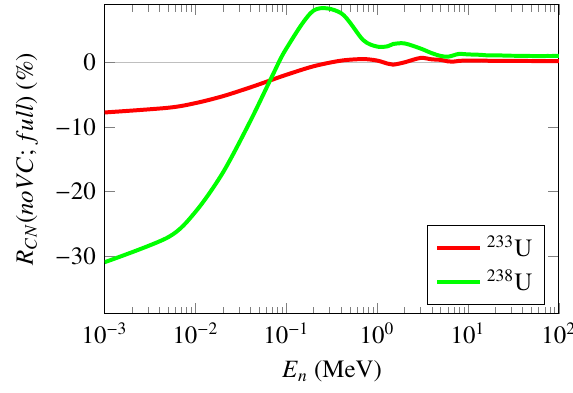
Figure 5. Change of CN formation cross section of axial rigid- rotor model with GS band coupling due to introduction of nu- cleus stretching (assuming SRM-based “e ff ective” deformations for GS band).